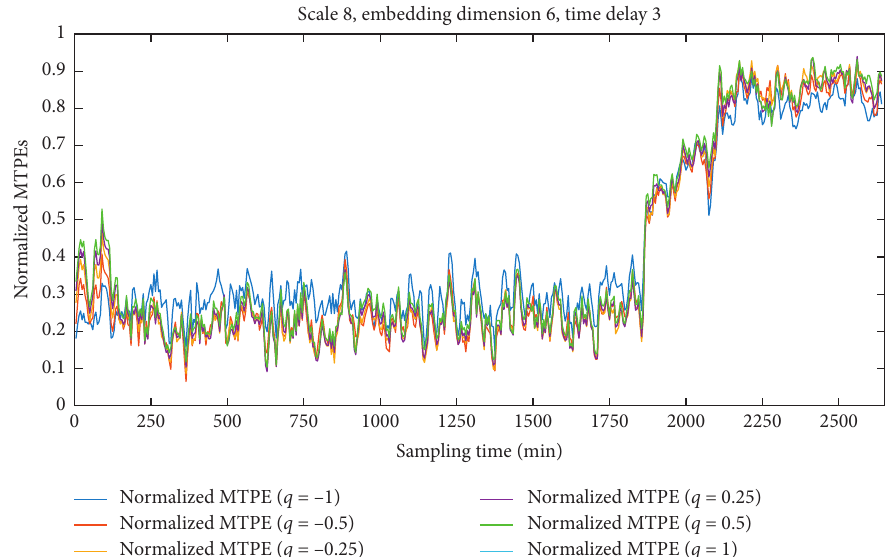
Figure 11: Results of health indicators on different entropy indices q .